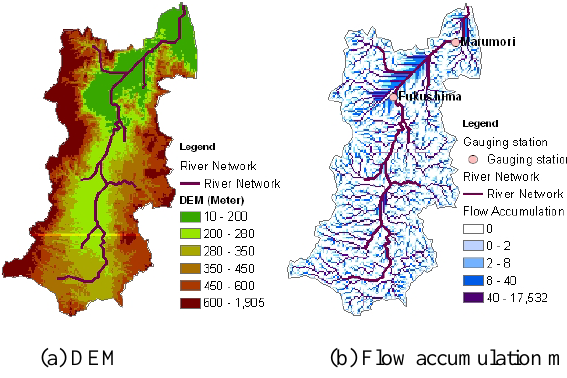
Fig. 6. Spatial data over view for Abukuma River Basin modelling.